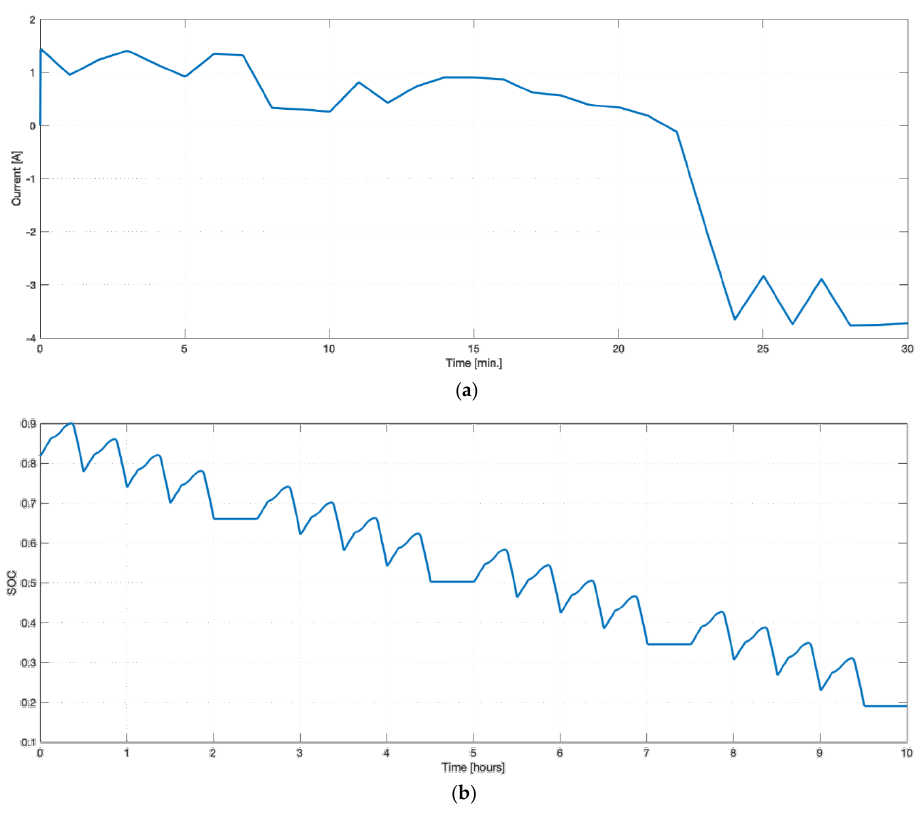
Figure 1. ( a ) Test 2 current versus time for one cycle and ( b ) Test 2 SOC versus